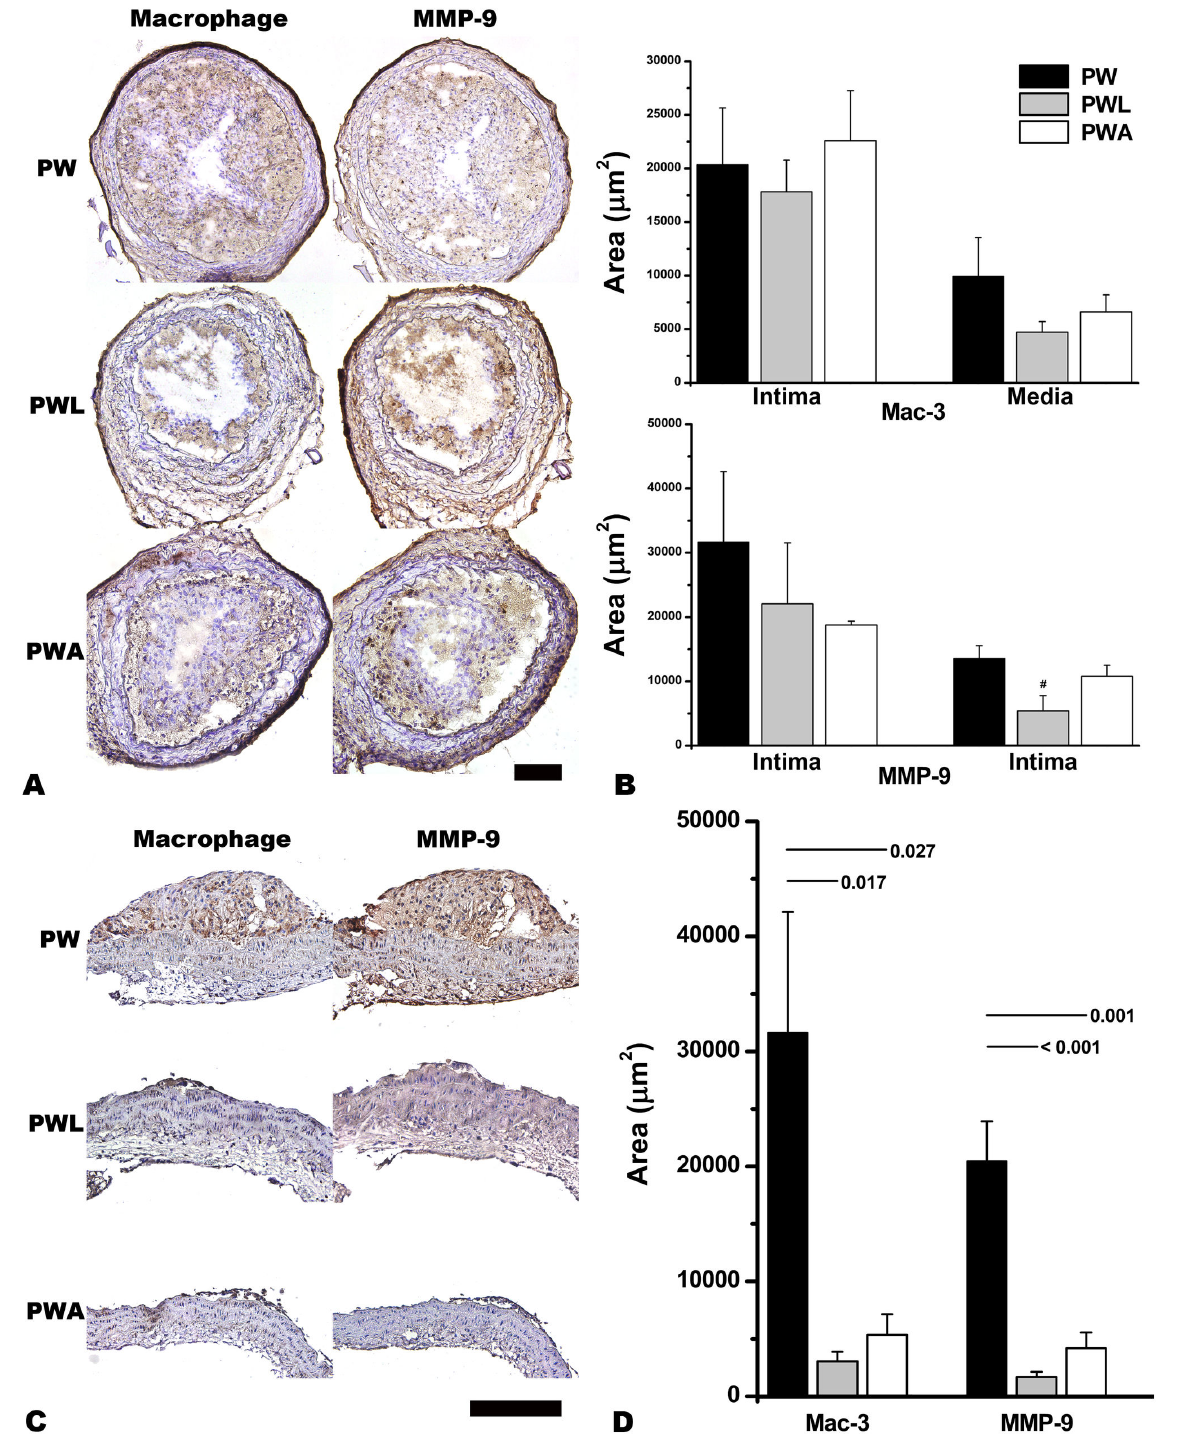
Figure 5. LiCl (PWL) or atorvastatin(PWA)-induced attenuation of plaque size and the extent of macrophage (Mac-3) or matrix metalloproteinase-9 (MMP-9) immunoreactivity in the aortic arch (C and D) but not in the left common carotid artery (A and B). PW denotes non-treated western-diet fed ApoE -/- mice with partial ligation-induced carotid atherosclerosis. Statistically significant p values from Mann-Whitney tests between groups are provided. MMP-9 immunoreactivity in the intima tends to be less extensive in the PWL group than in the other groups (B, # p = 0.083). Scale-bars, 100 µm. doi: 10.1371/journal.pone.0073451.g005 PLOS ONE |